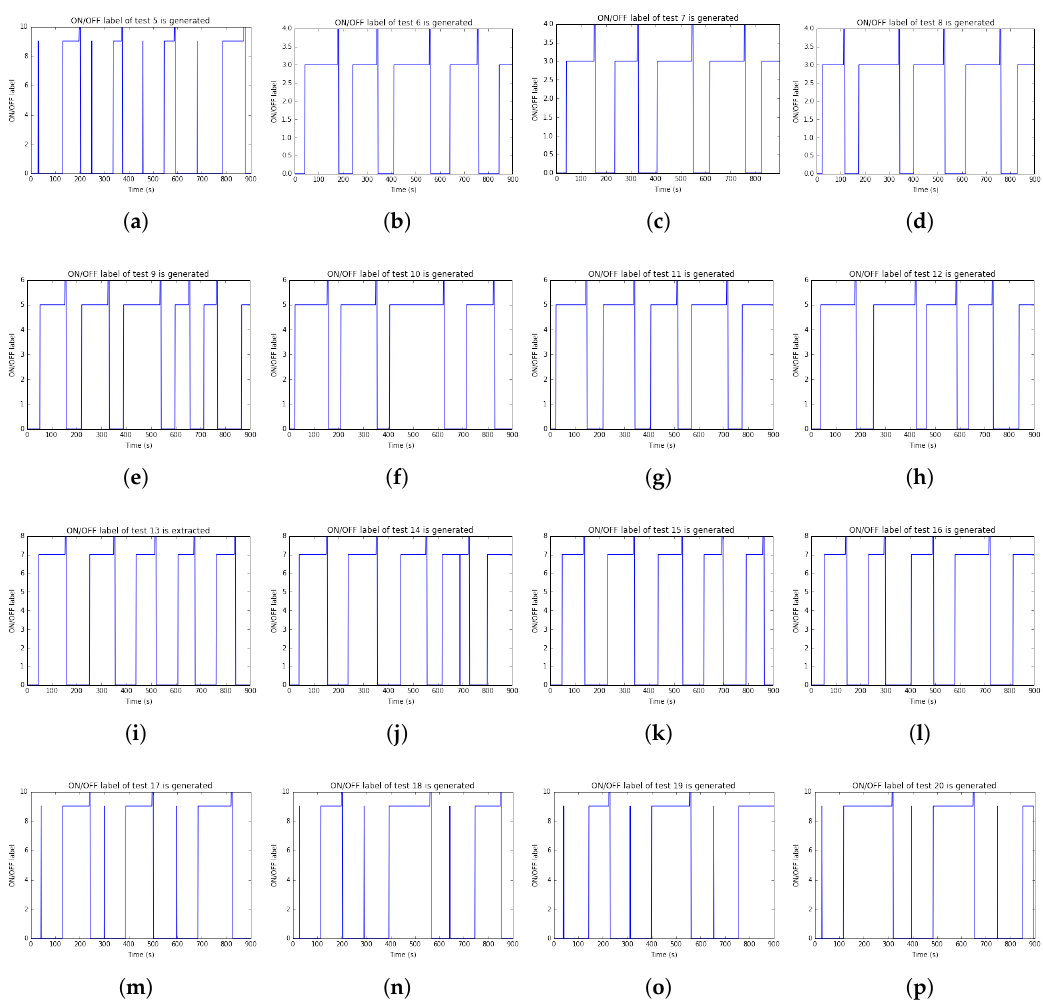
Figure A3. ON/OFF labels of test 5 to test 20